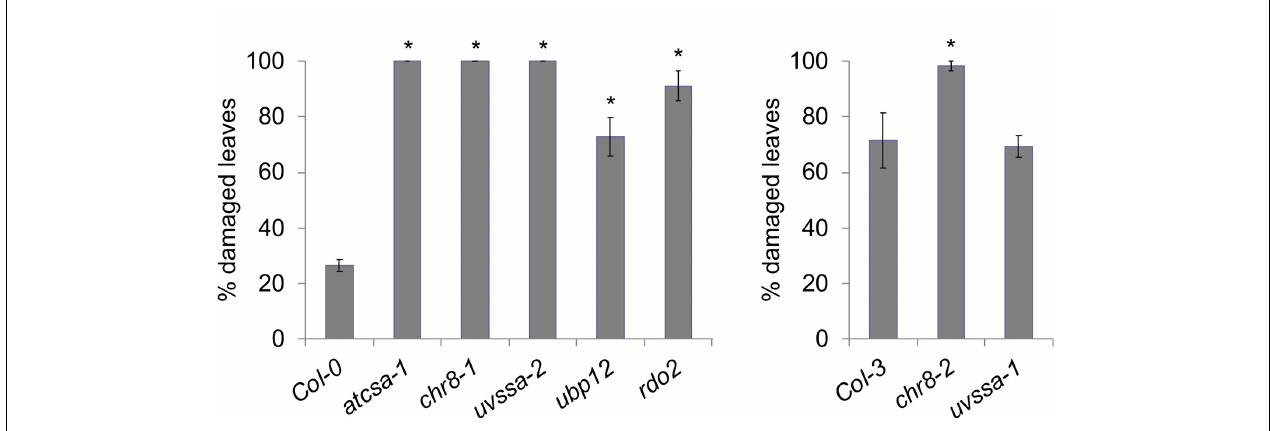
FIGURE 5 | UV tolerance in adult plants. Percentage damaged leaves after 500 J m − 2 UV treatment, followed by 3 days of dark incubation. Values are means ± SE ( n = 6), ∗ p ≤ 0.05 of mutants vs respective wild